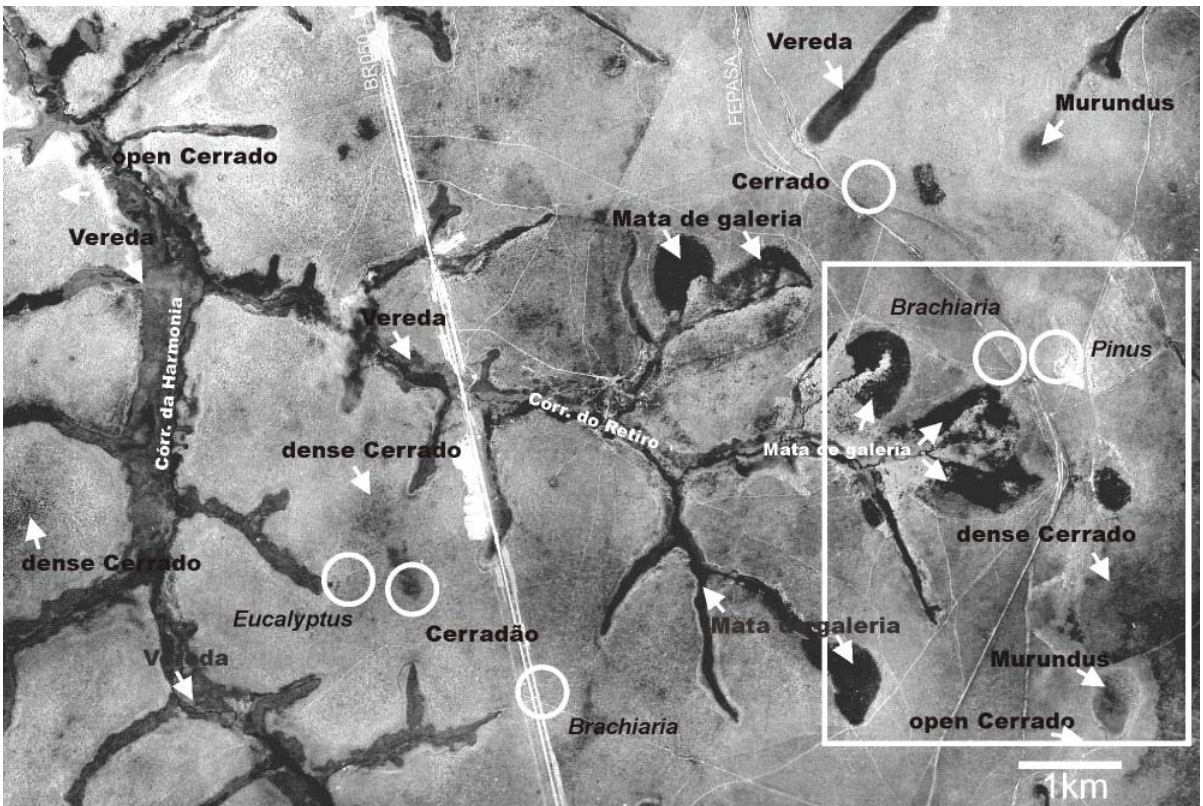
Figure 2. Aerial photograph of the study region from 1964. Circles highlight the study sites, which were under natural vegetation at the time. The different vegetation forms occurring in the region are marked with arrows. The frame shows the position of the aerial photograph from